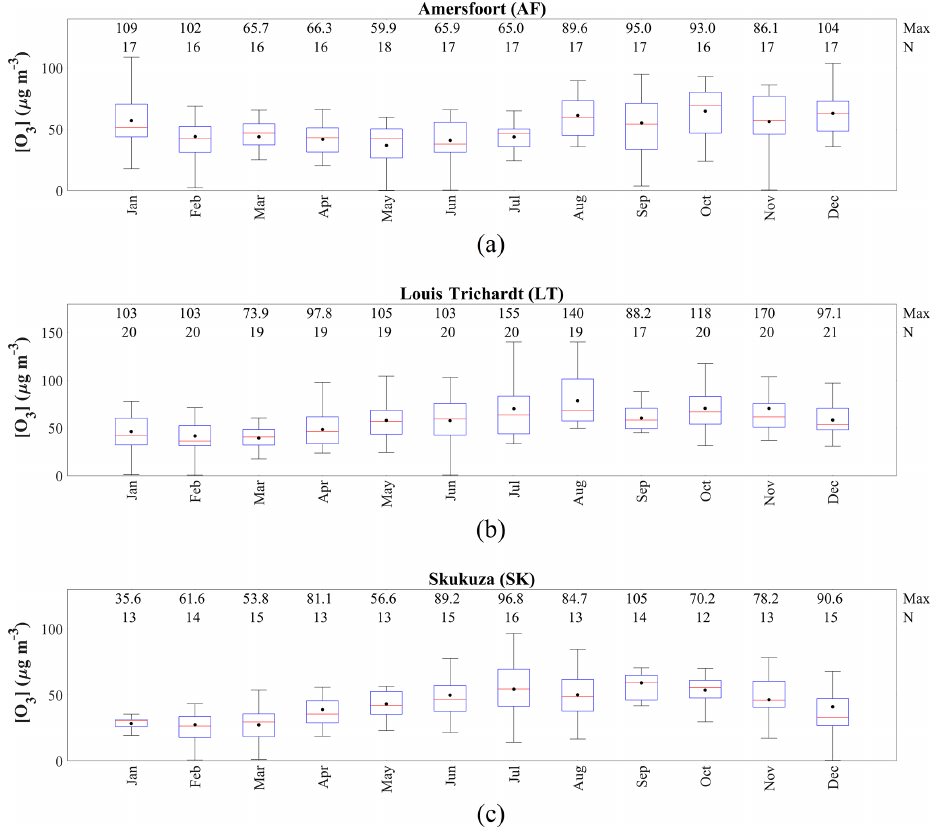
Figure 5. Monthly O 3 concentrations measured at (a) AF from 1997 to 2015, (b) LT from 1995 to 2015 and (c) SK from 2000 to 2015. The red line of each box represents the median; the top and bottom edges of the box represent the 25th and 75th percentiles, respectively; the whiskers are ± 2 . 7 σ (99.3% coverage if the data have a normal distribution); and the black dots represent the averages. The maximum concentrations and the number of measurements ( N ) are presented at the